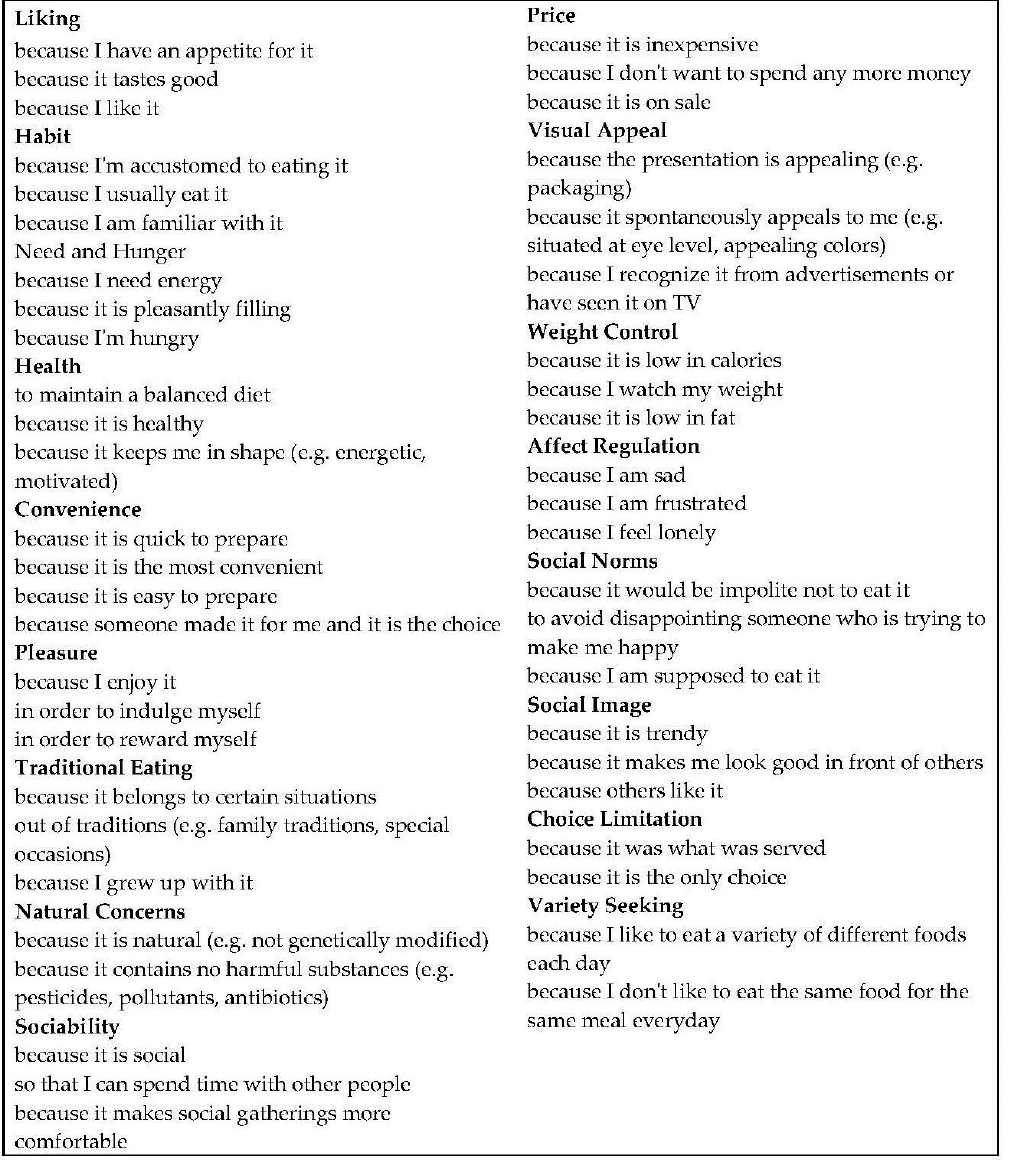
Figure 1. Modified version of The Eating Motivation Survey used in this study. This questionnaire included 49 motivation subscales measuring 17 motivation constructs. Reproduced with permission from Chambers and Phan, Journal of Sensory Studies, Wiley Blackwell, 2016 [11].